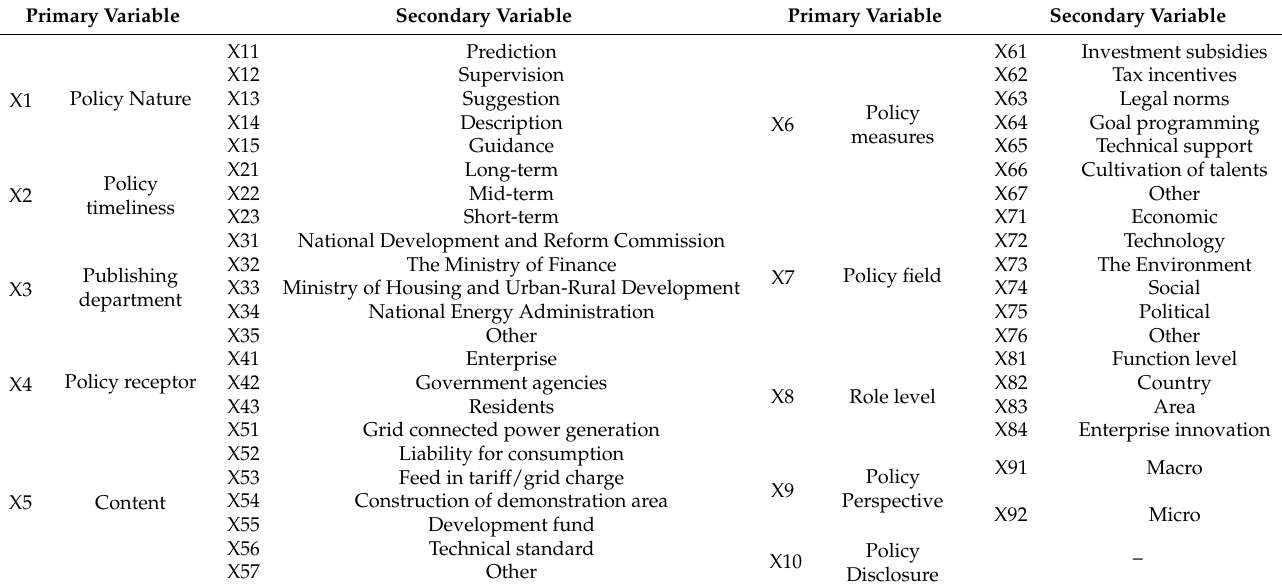
Table 5. Policy indicators for the wind power industry.